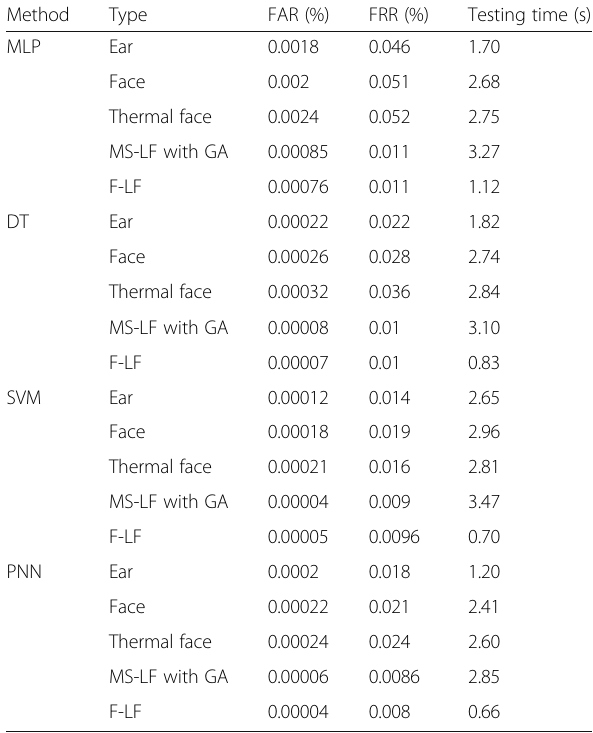
Table 11 FAR, FRR, and testing time results for each method used in the experiments